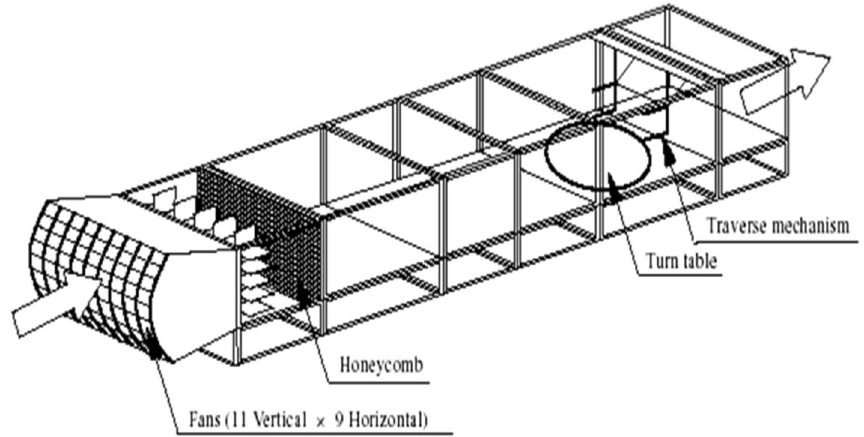
Fig. 5 Sketch map of the tri-dimensional multi-fan wind